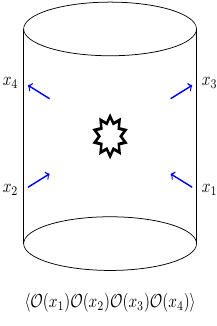
Figure 1: A bulk ‘scattering